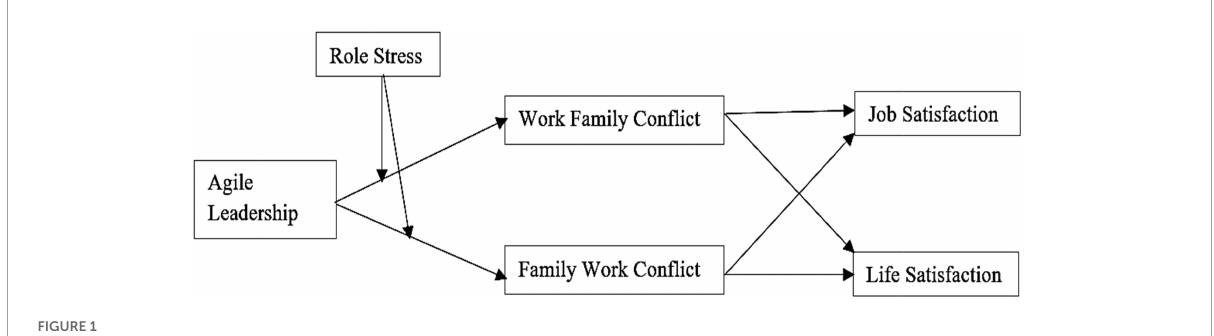
FIGURE1 Proposed conceptual